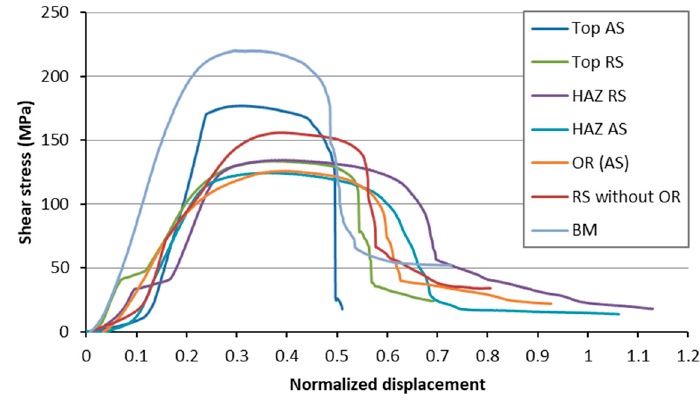
Figure 13. Shear punch test result for sample T4. Table 3. Shear stress and UTS in different locations in sample T4.